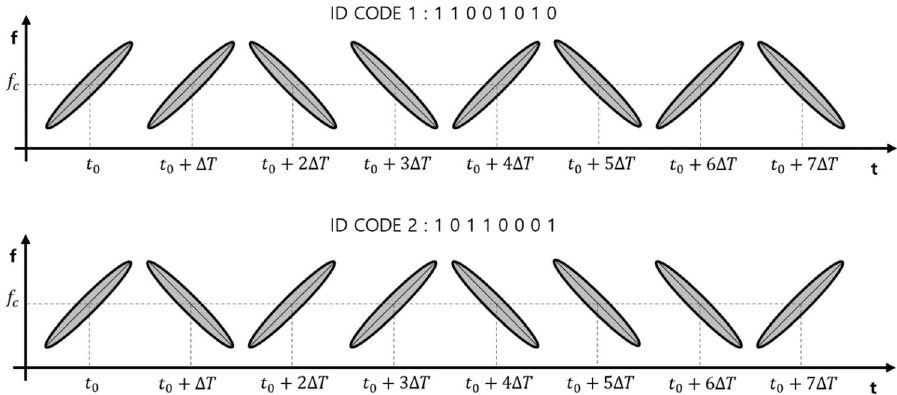
Figure 4. Example of the received signal according to the code on the